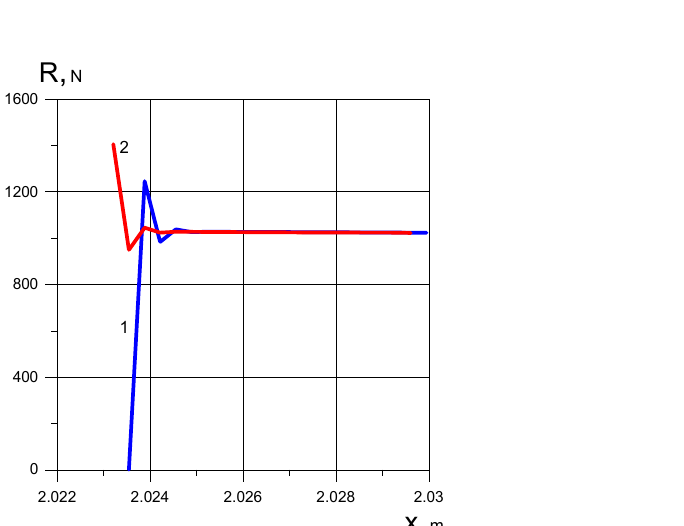
Figure 7 – Calculated reaction values R of the guide along the length x of the initial part of the spatial motion of the projectile at θ 0 = 33 0 36' and different initial values of the deformation of the guide tube at the point of contact: 1 - no deformation; 2 - deformation on a force equal to the projectile